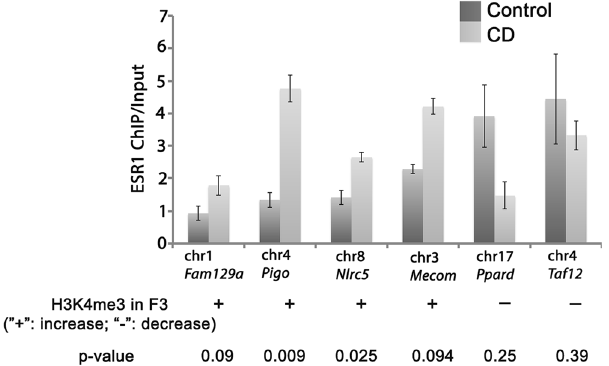
Figure 6. ESR1 binding is altered in CD treated testes. The ChIP was performed using antibody against ESR1 in E15.5 testis. The immunoprecipitated DNA was quantitated with fluorescent method and equal amount of ChIP and Input DNAs was taken for each PCR using the primers indicated in SI. The ESR1 predicted binding sites were obtained by FIMO analysis and primers were designed after repeat masking of each target sequence. The copy number for each gene was normalized for quantity to control region without ESR1 binding sites ( Gapdh gene) and compared to Input. The data was expressed as ChIP-to-input